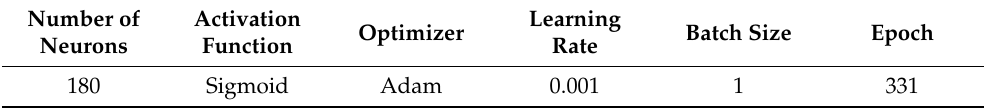
Table 3. Super parameter values of the LSTM model. Number of Activation Optimizer Neurons Function